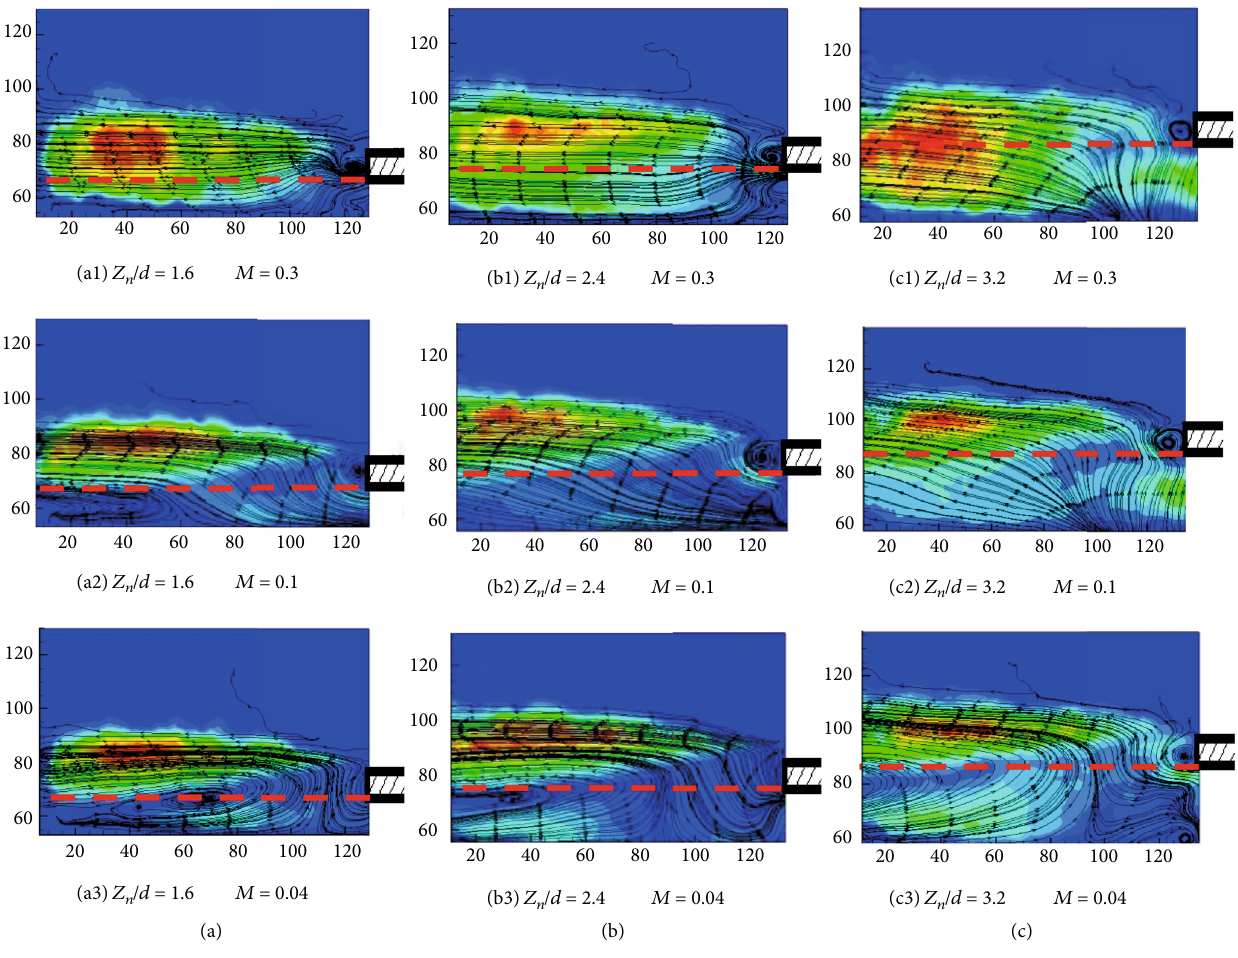
Figure 10: Flow fi eld pattern at di ff erent jet-to-plate